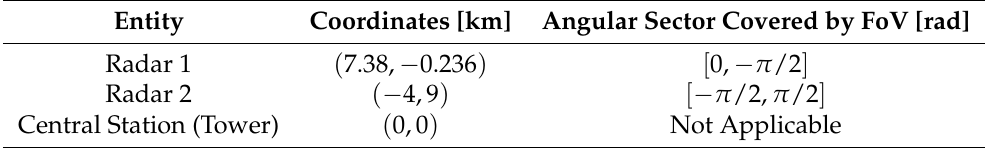
Table 1. Radars and Central Station in